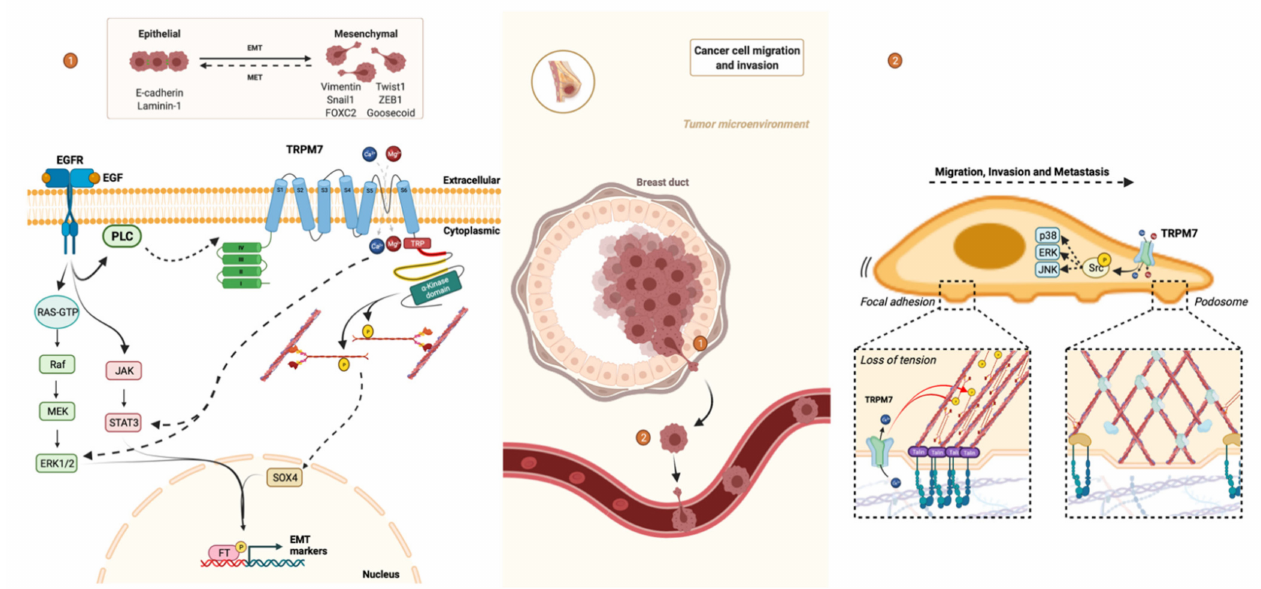
Figure 3. The TRPM7 ion channel is involved in: (1) the epithelial-mesenchymal transition (EMT); and (2) cell migra- tion/invasion in breast carcinoma. Cells must convert their epithelial-like phenotype to mesenchymal-like phenotype in order to acquire a more invasive profile. This involves the loss of cell contacts, modification of the cytoskeleton and increased cell migration and invasion. Breast cancer cells overexpress the TRPM7 channel, a chanzyme. The epidermal growth factor (EGF) allows an increase in the influx of calcium via the EGFR-phospholipase C (PLC) signaling pathway allowing the activation of the channel activity of TRPM7. The elevation of cytosolic calcium induces activation of ERK1/2 and the signal transducer and activator of transcription 3 (STAT3), participating in the expression of vimentin, markers of EMT. The kinase activity of TRPM7 allows phosphorylation (P) of the heavy chain of myosin II (MHC) on the domain responsible for the assembly of myosin filaments, inducing decoupling of the cytoskeleton and cytoskeleton relaxation. Relaxation is associated inversely with regulation by cytoskeletal tension of SRY-Box Transcription Factor 4 (SOX4) expression, participating in the transcription of mesenchymal markers such as Snail1, FOXC2, GSC, SIX1, Twist1, HOXB7 and ZEB1. In addition, MHC phosphorylation by TRPM7 promotes local relaxation of cortical tension and leads to the control of cell-cell adhesion and the transformation of focal adhesions into podosomes, participating in polarized cell movement. The association of TRPM7 with the actomyosin cytoskeleton is Ca 2+ -dependent, which means that the ion influx partly regulates the kinase domain via the interaction with its substrates. TRPM7 is also involved in the phosphorylation of Src and the downstream recruitment of signal molecules such as p38, ERK, JNK, involved in the migration, invasion and metastasis development of breast cancer cells. Created using source BioRender.com source, accessed on 5 October